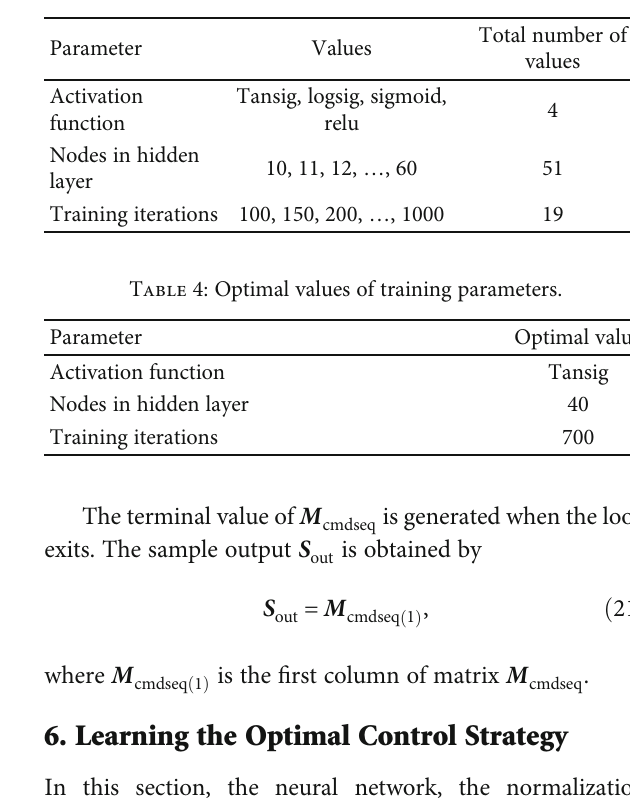
Table 3: Training parameters.